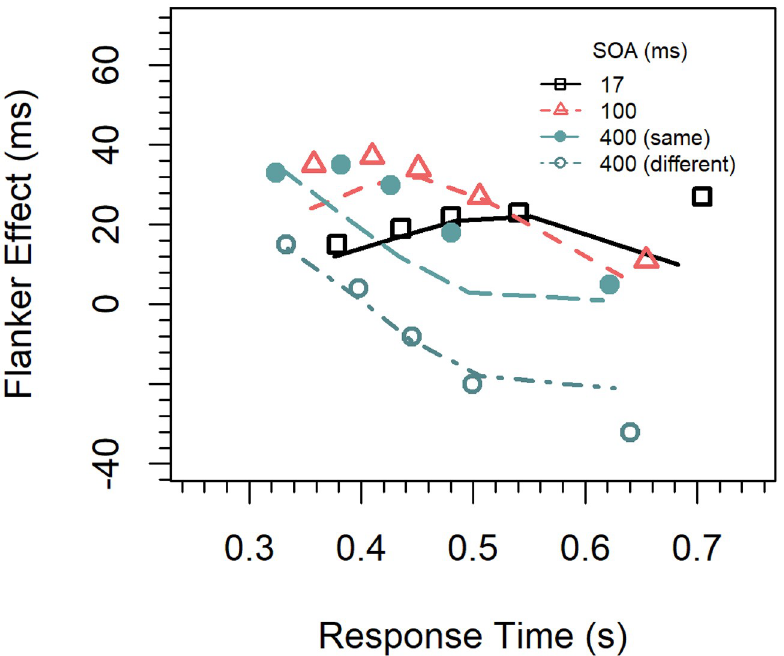
Fig 6. Delta functions for the different conditions in Experiment 2 (data points). The lines represent the fit of the DMC model.